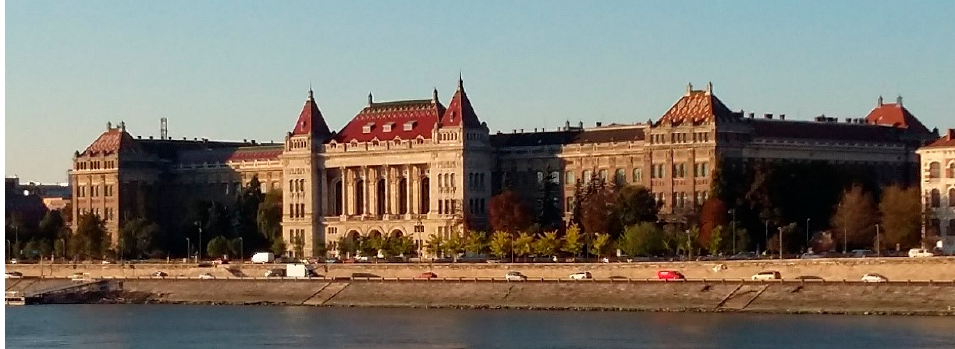
Figure 2. Budapest University of Technology and Economics (BME) Central Building.